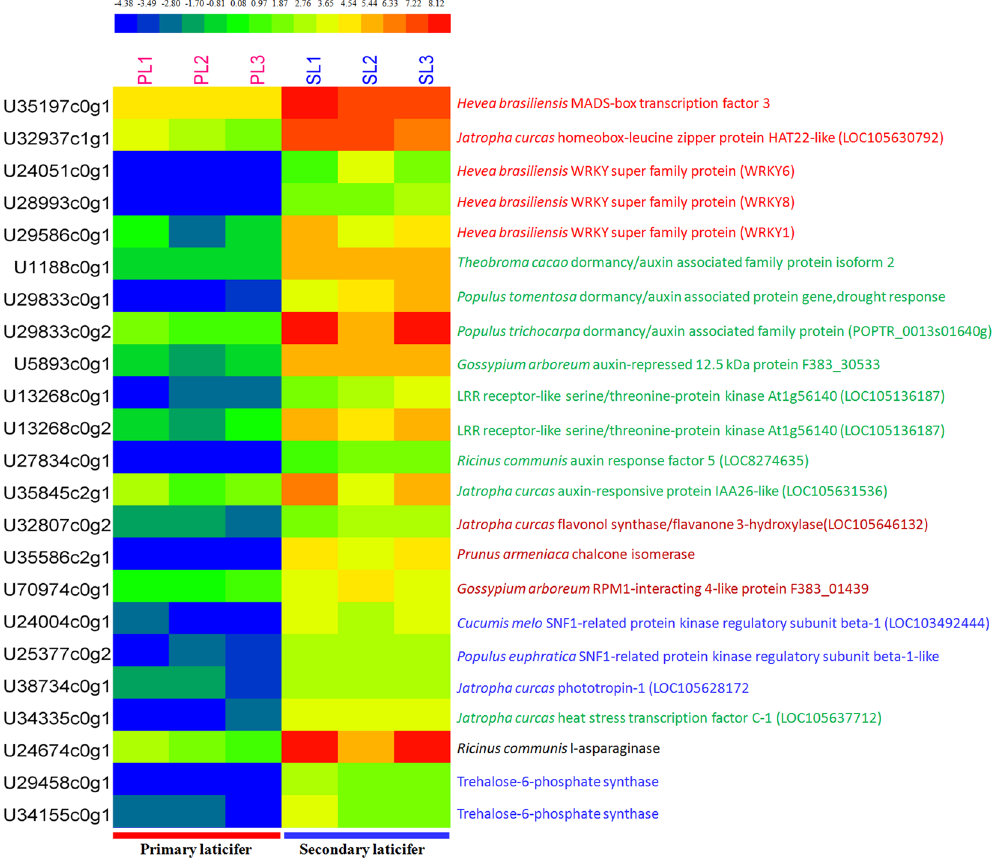
Figure 7. Heatmap of DEGs involved in abiotic stresses. The expression levels of DEGs in TPM were compiled with Excel 2007, normalized using a log2 base method, and exported to the HemI toolkit 124 . The figure was built using the default parameters. The expression levels are presented in different colors, and the values are defined in the scale bar. PL, the primary laticifers; SL, the secondary laticifers.